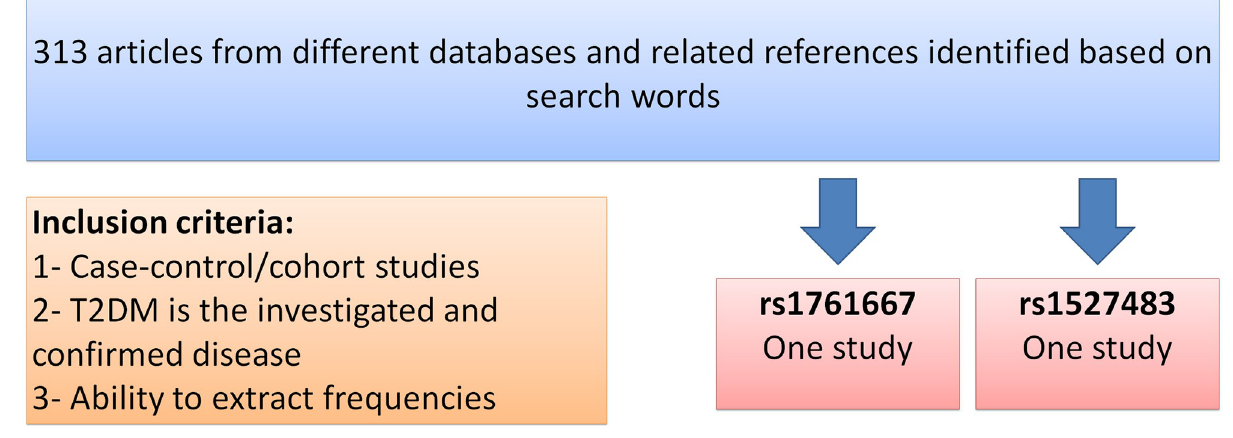
Fig 9. Meta-analysis flow chart and inclusion